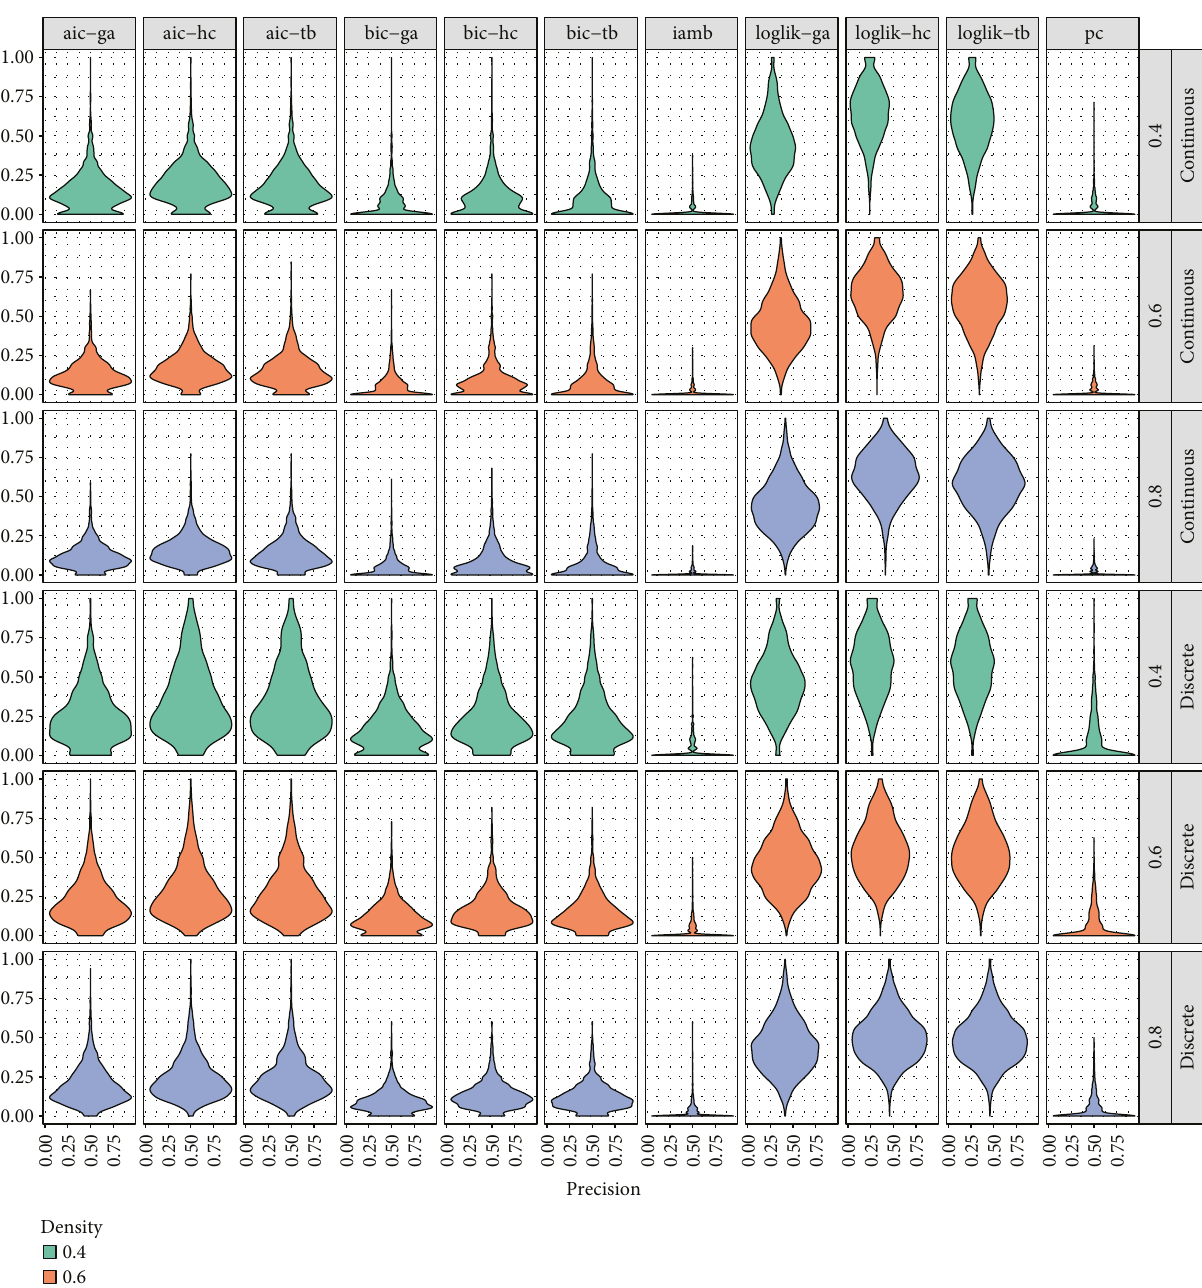
Figure 4: Violin plots showing precision and recall of the solutions obtained by the 11 tested approaches, grouped by the type of dataset (discrete and continuous) and density values (0.4, 0.6, and